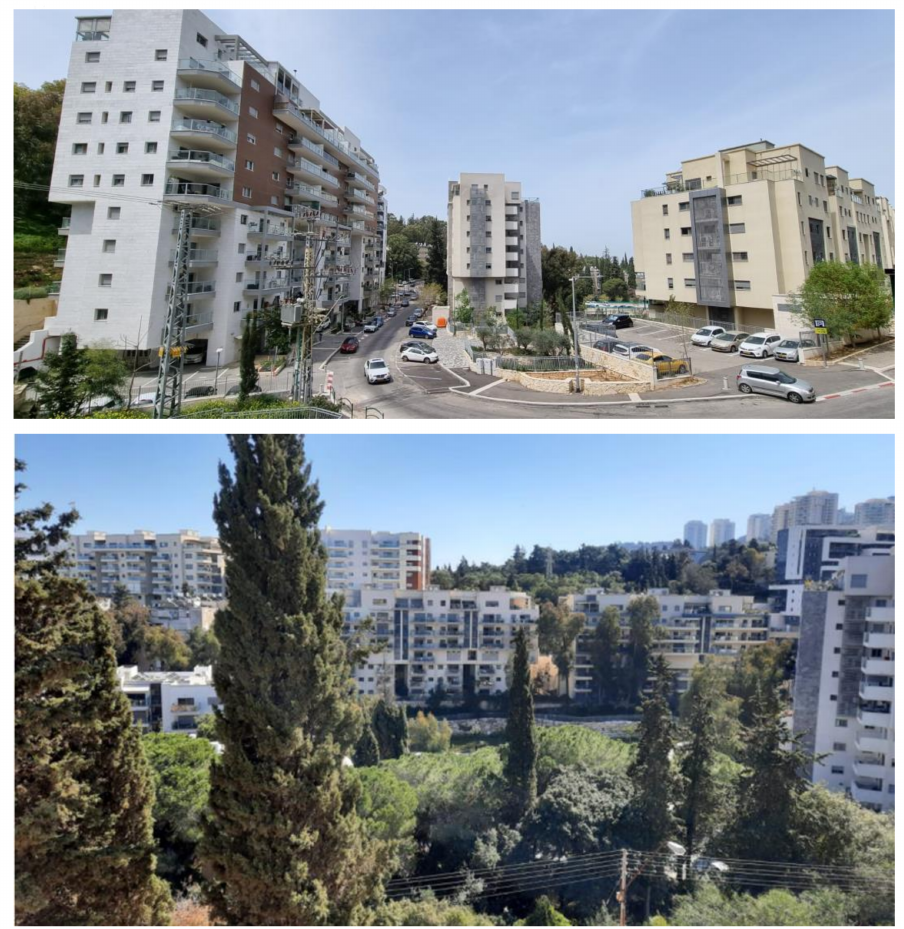
Figure 7. The renewed buildings, photographed by the authors,